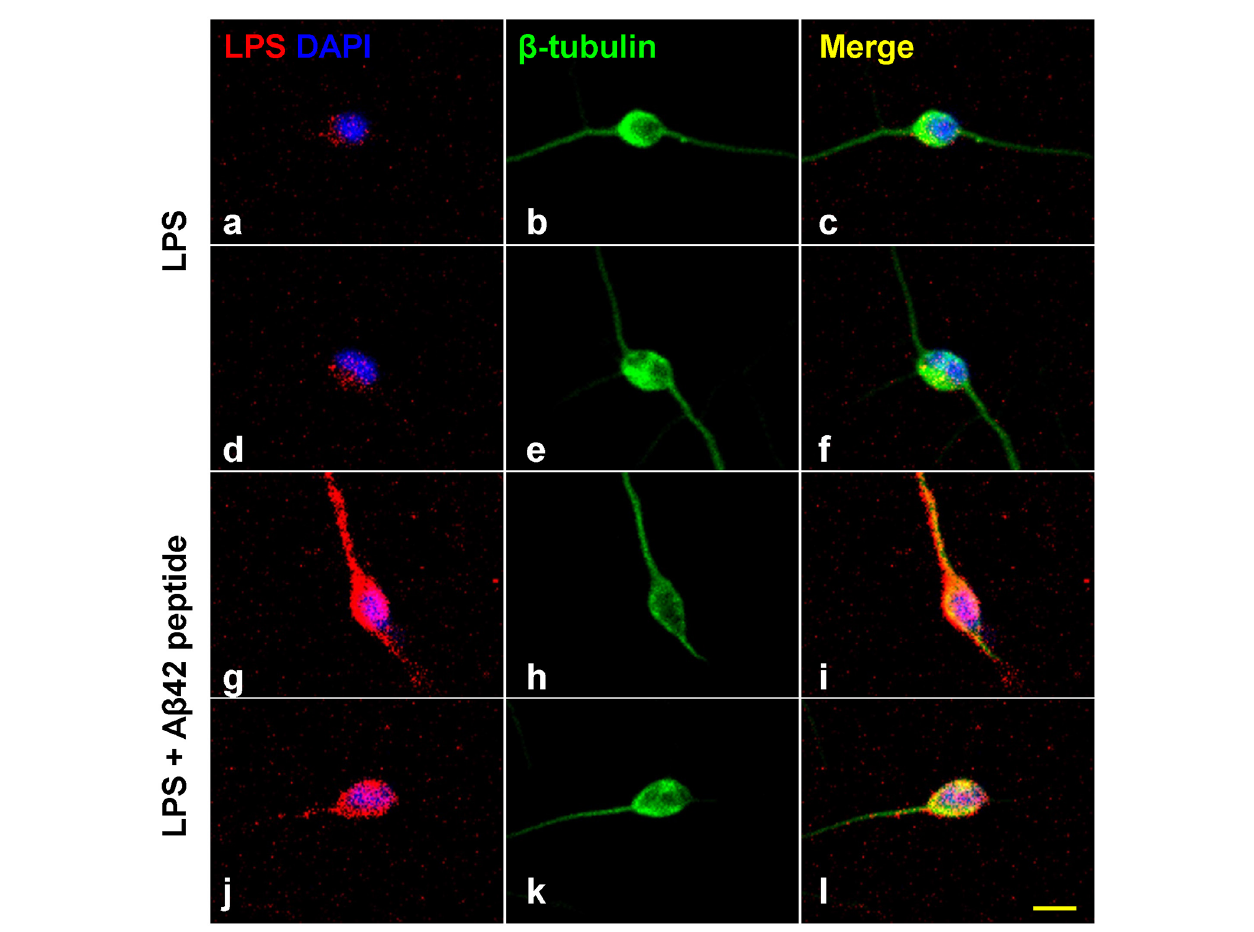
FIGURE 2 | Increased affinity of LPS for neuronal nuclei in the presence of A β 42 peptide. Panels (A–L) show LPS-neuronal interactions in the presence or absence of A β 42 peptide; (A–F) in the absence of A β 42 peptide and (G–L) in the presence of A β 42 peptide. LPS preferentially associates with human neuronal nuclei both in Alzheimer’s disease (AD) and in LPS-addition experiments (Zhao et al., 2017a,b,c; Zhao and Lukiw, 2018a,b). Panels (A,D) show LPS (red) affinity for a polar region of a single DAPI-stained neuronal nucleus (blue). Panels (B,E) show single neuronal nucleus stained with neuron-specific β -tubulin III (green). Panels (C,F) show merged stain indicating LPS affinity for the polar region involving a single DAPI-stained neuronal nucleus. Panels (G,J) show the presence of A β 42 significantly increases the affinity of LPS for single DAPI-stained neuronal nucleus. Panels (H,K) show single neuronal nucleus stained with neuron-specific β -tubulin III (green). Panels (I,L) show merged stain indicating LPS affinity for the neurite and soma of a single DAPI-stained neuronal nuclei. The results suggest that LPS is stimulated to associate with DAPI-stained neuronal nuclei in the presence of the hydrophobic A β 42 peptide; neither A β 40 peptide or β -actin showed comparable “association” effects (Zhao et al., 2017a,b,c; Lukiw et al., 2018); yellow scale bar (lower right) = 50 µ